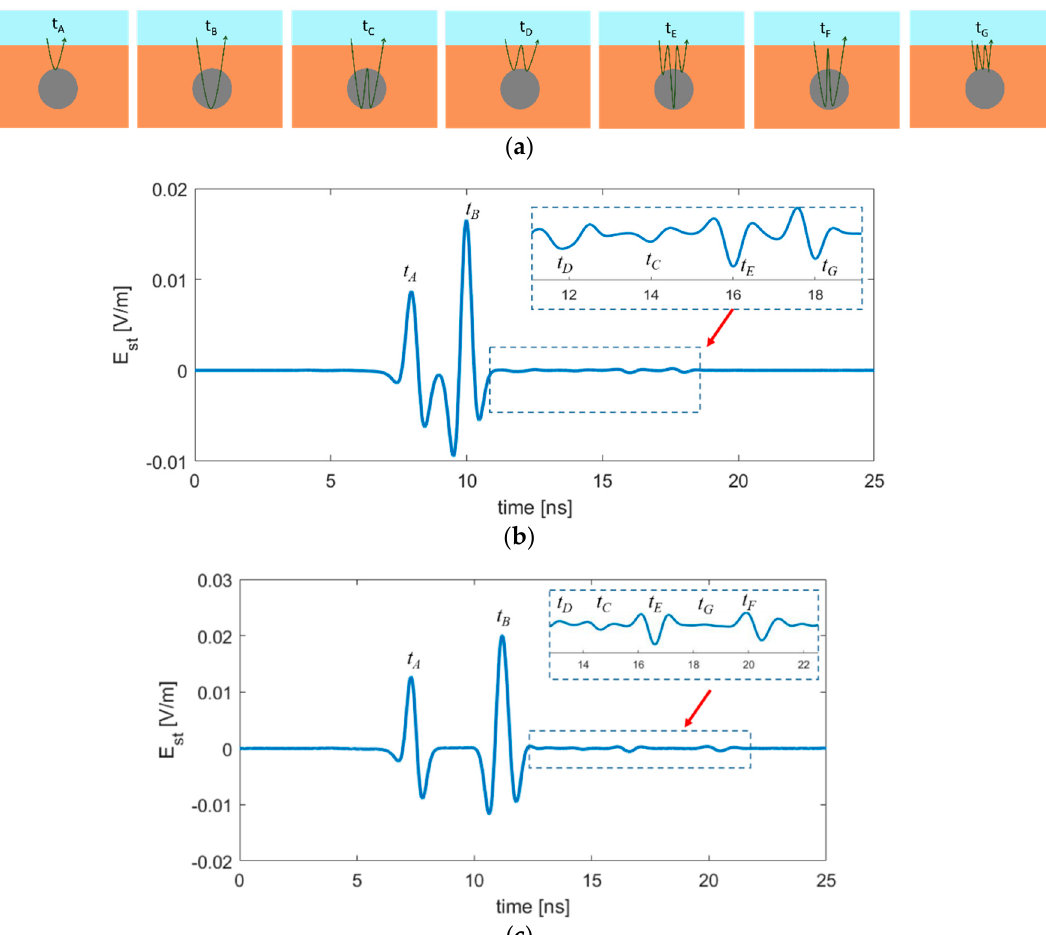
Figure 5. ( a ) Scheme of the arrival times, highlighting the di ff erent paths between the interface and the cylinder and inside the cylinder; ( b ) A-scan radargrams relevant to the B-scan in Figure 4 for a receiver aligned with the cylinder at the probing distance z = 0.7 m (receiver #21) with radius a = 5 cm; ( c ) the same as in ( b ), with radius a = 10